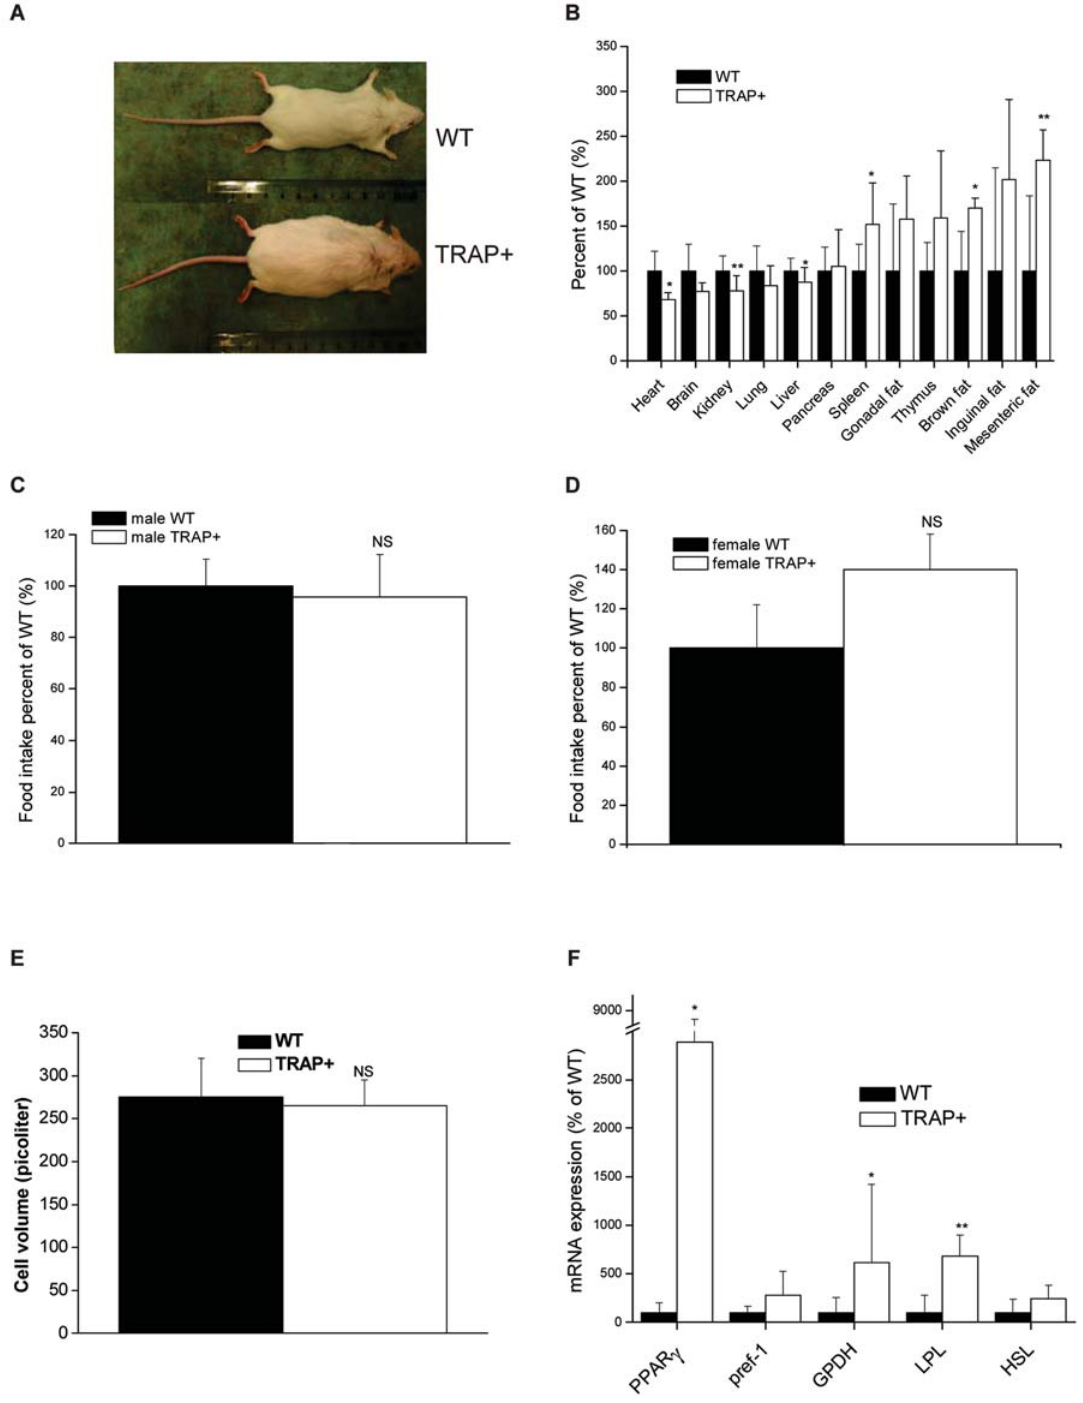
Figure 1. A transgenic TRAP over expressing mouse subline displays hyperplastic obesity. (A) Photograph of lean WT and obese TRAP + mice. (B) Relative organ mass in TRAP + compared to WT mice. (C) Food intake in male WT and TRAP + mice. (D) Food intake in female WT and TRAP + mice. (E) Adipocyte volume in WT and TRAP + mice. (F) mRNA expression of adipocyte genes in adipose tissue from WT and TRAP + mice.